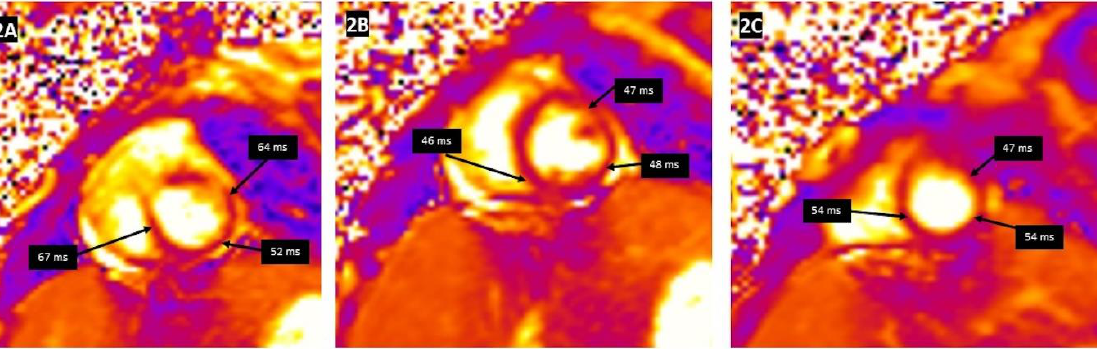
Figure 2. T2 mapping demonstrating the regional increase in myocardial T2 relaxation times at the basal anteroseptal and anterolateral segments ( A ), with normal T2 times at the mid-ventricular level ( B ) and the apex ( C ). Clinical vignette: A 20-month-old female with myocarditis associated with rhino/enterovirus, rapid left ventricular ejection fraction recovery from 24% to 48%, elevated troponin, and diffuse low voltage QRS complexes on electrocardiogram. There was no evidence of myocardial delayed enhancement after gadolinium contrast emphasizing the additional utility of T1 and T2 mapping in the evaluation of myocarditis.